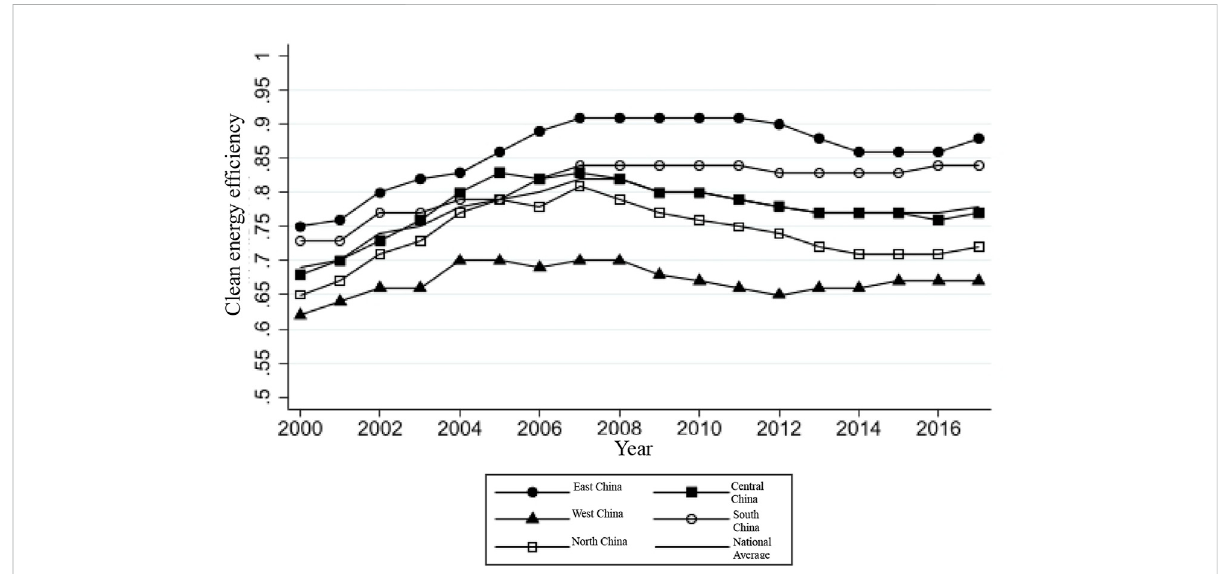
FIGURE 3 2000-2017 clean energy ef fi ciency structure of China (new energy).